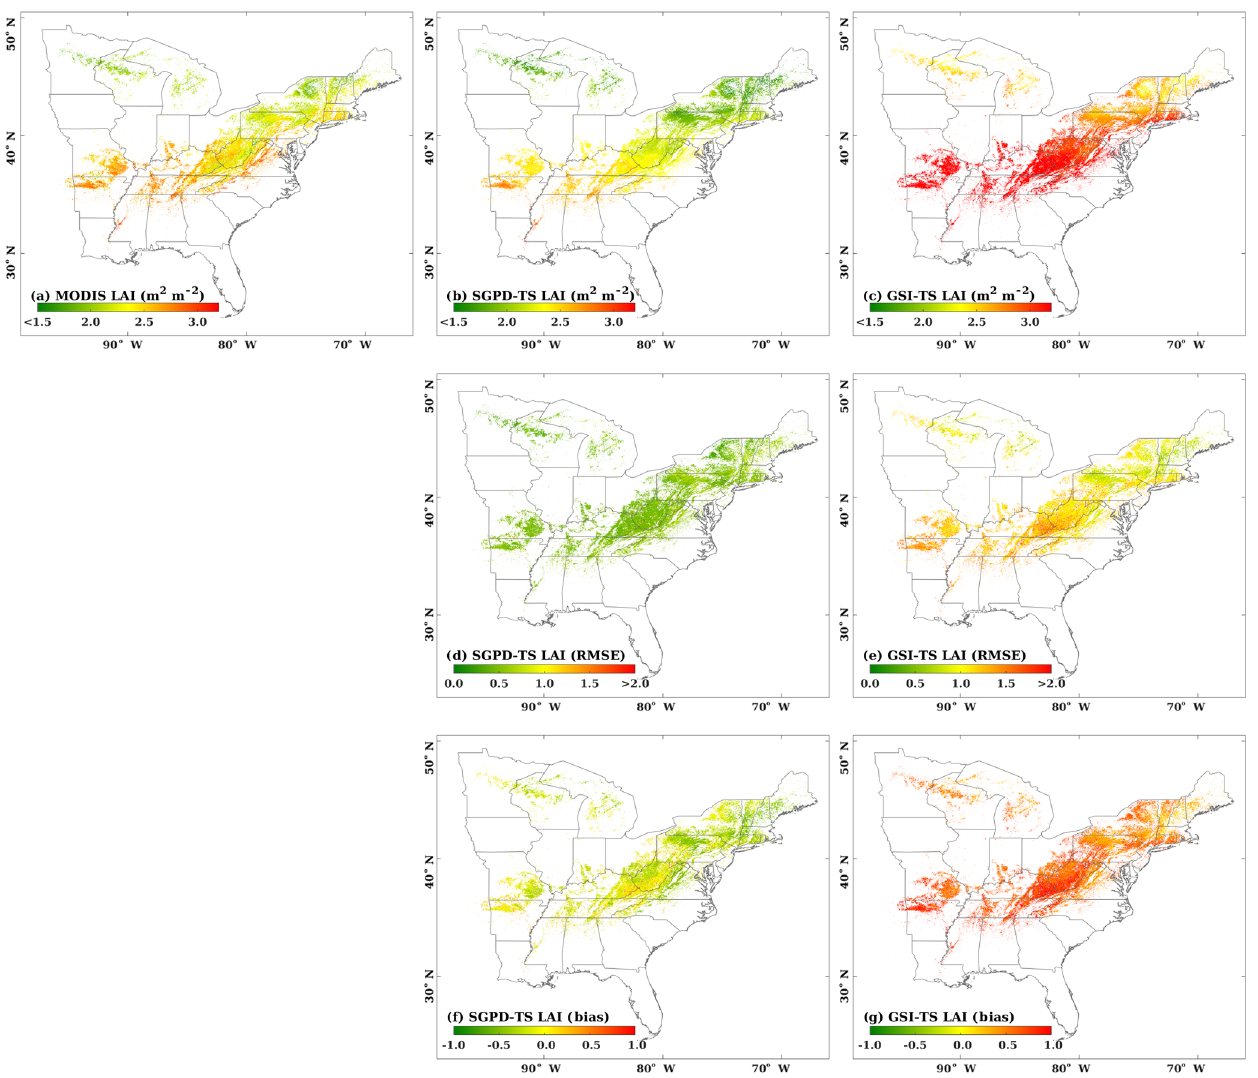
Figure 4. The spatial distributions are shown for (a) the 2001–2010 mean MODIS LAI, (b) the 2001–2010 mean SGPD-TS LAI, (c) the 2001–2010 mean GSI-TS LAI, (d) RMSE between SGPD-TS LAI and MODIS LAI, (e) RMSE between GSI-TS LAI and MODIS LAI, (f) MBE between SGPD-TS LAI and MODIS LAI, and (g) MBE between GSI-TS LAI and MODIS LAI across the eastern United States. The units for both RMSE and MBE are m 2 (leaf area) per m 2 (ground area).